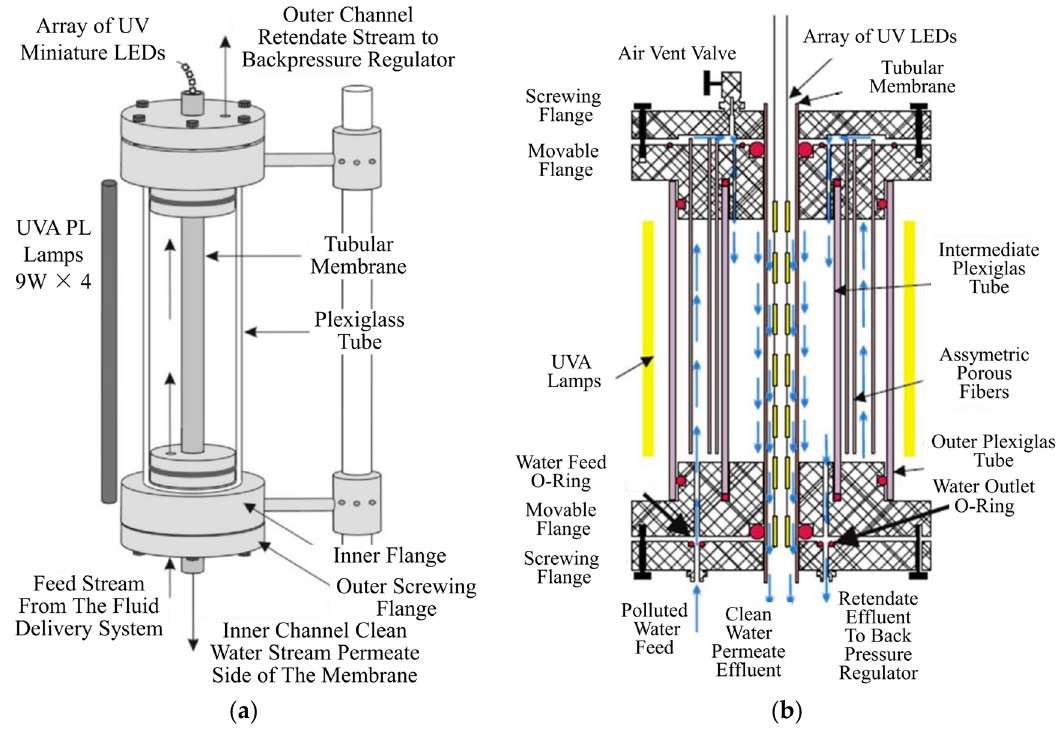
Figure 6. Schematic diagram of a ( a ) primary; ( b ) improved continuous flow PMR with double ‐ side active TiO 2 modified membrane for water purification. Adapted with permission from [61,63], Copyright Elsevier,